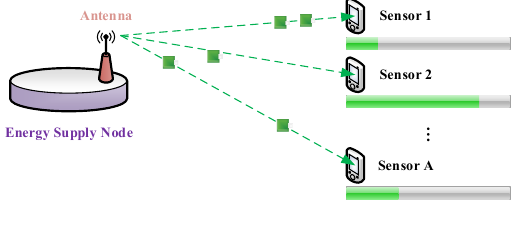
Figure 3. Energy supply system